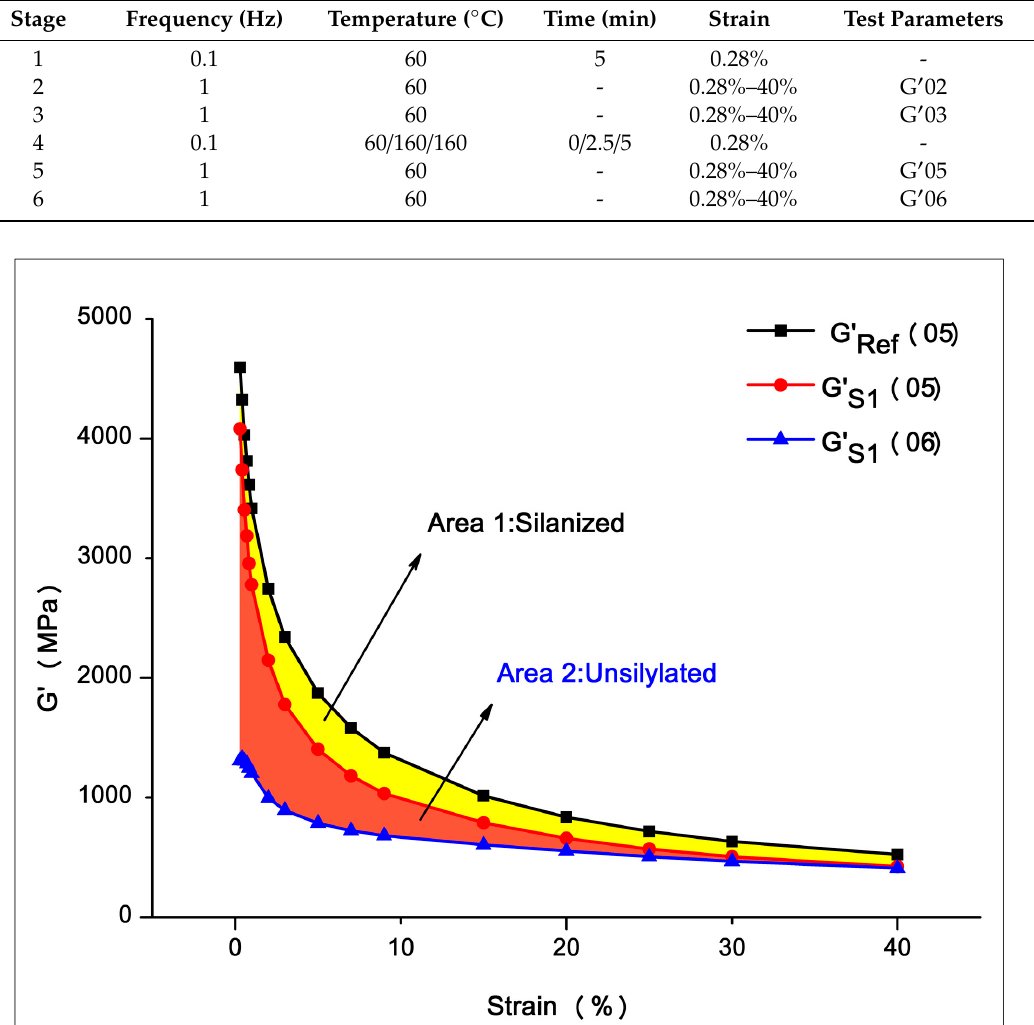
Figure 9. Test principle of the silanization reaction degree.